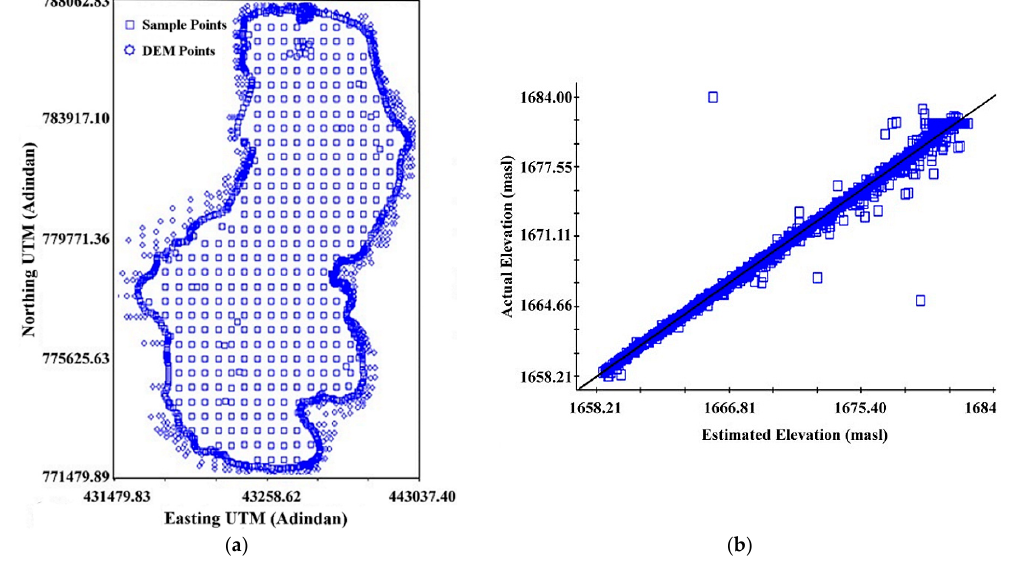
Figure 4. Spatial dataset. ( a ) Grid of sampling points; ( b ) cross-validation analysis graph.